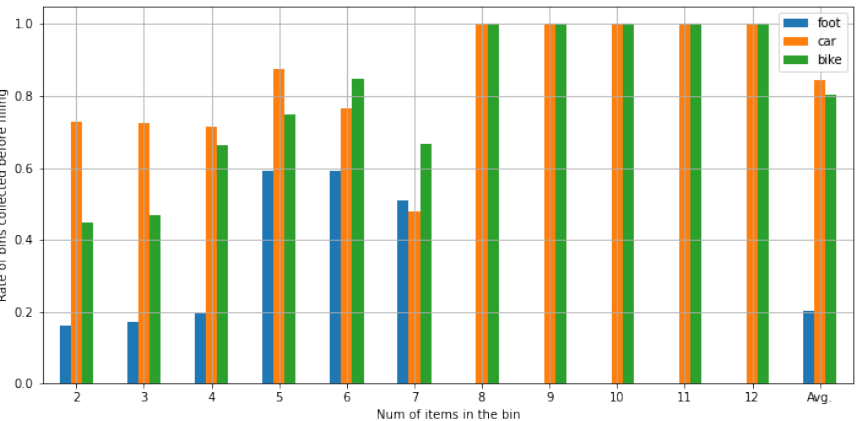
Figure 12. Collection rate per means of transport and number of items in the